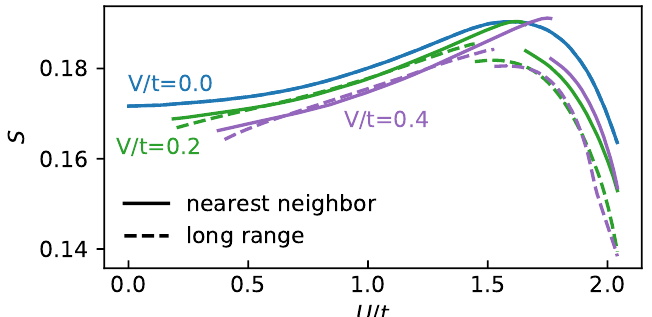
Figure 3: (Color online) U dependence of the entropy per lattice site for T / t = 0.083 and different strengths of the nearest-neighbor (solid lines) and long-ranged Coulomb interaction (broken lines). Only data for U > V are